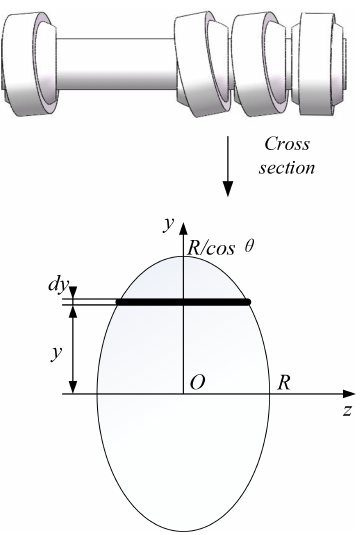
Figure 6. Selecting the polar moment of the inertia